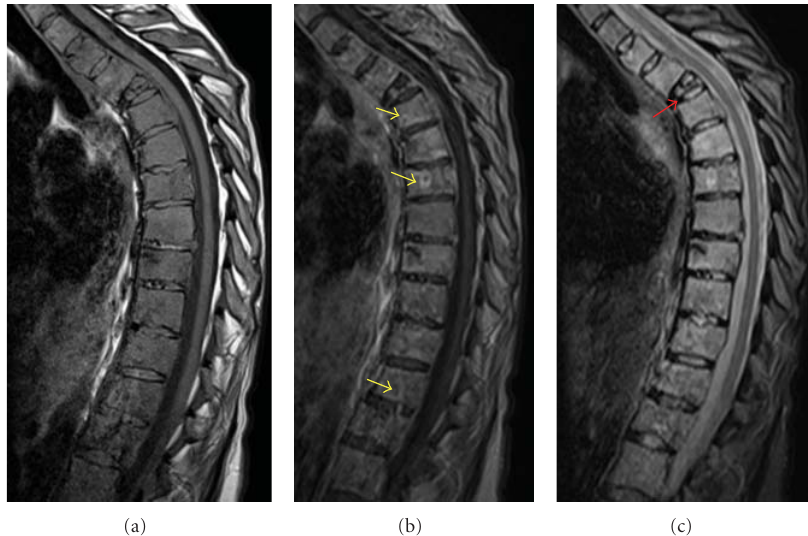
Figure 5: Sagittal T1-weighted MR image (a) of the thoracic spine illustrates di ff use marrow hypointensity, which is slightly hypointense relative to the discs. Given the di ff use marrow involvement, it may be di ffi cult to discern this marrow abnormality. Gadolinium-enhanced T1-weighted MR image (b) depicts multiple heterogeneously enhancing lesions (yellow arrows). The STIR MR image (c) shows abnormally increased signal in the posterior elements and the vertebral bodies. A compression fracture is seen in the upper thoracic spine (red arrow).